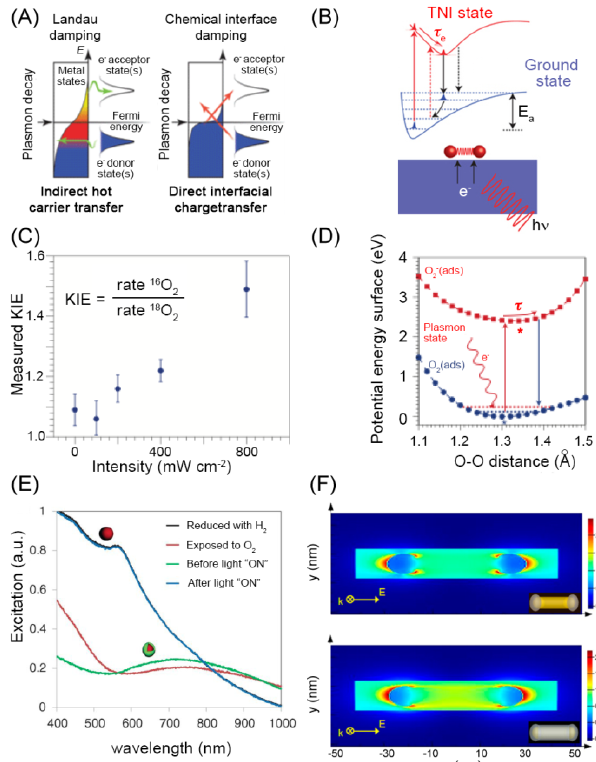
Figure 6: (A) Energy diagram of plasmon-promoted non-radiative charge transfer through Landau damping (left) and Chemical In- terface Damping (right). (B) Schematics of the mechanism called Desorption Induced by Electronic Transition (DIET) involving the Transient Negative Ion (TNI) formation. (C) Dependence of Kinetic Isotope Effect (KIE) on the irradiation source intensity. (D) DFT- calculated PES for O 2 and the corresponding TNI O − 2 , formed upon plasmon activation on the surface of Ag nanocrystals ( * = equilib- rium state and τ = evolution of TNI on the potential energy surface as a function of time). (E) UV-vis extinction spectra of Cu/SiO 2 cata- lyst under different experimental operating conditions. (F) 3-D FDTD simulation of the spatial distribution of LSPRenhanced electric field for Pd-tipped (top) and Pd-covered (bottom) Au NRs (E = electric field vector and k = wavevector). Figures (A–F) adapted with permis- sion from references [13, 14, 56, 116] and [132], respectively.